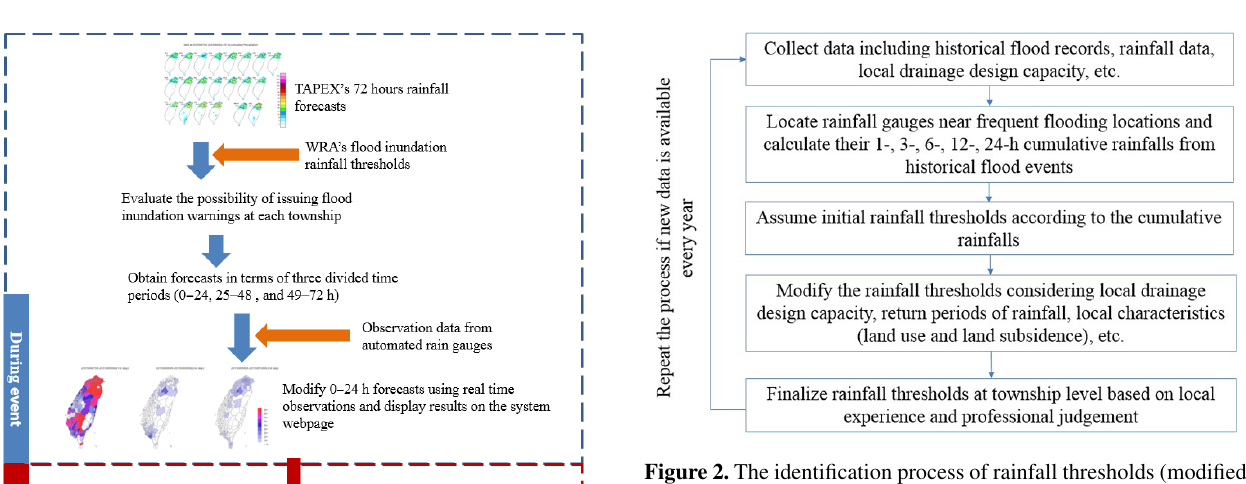
Figure 2. The identification process of rainfall thresholds (modified from Wu and Wang,